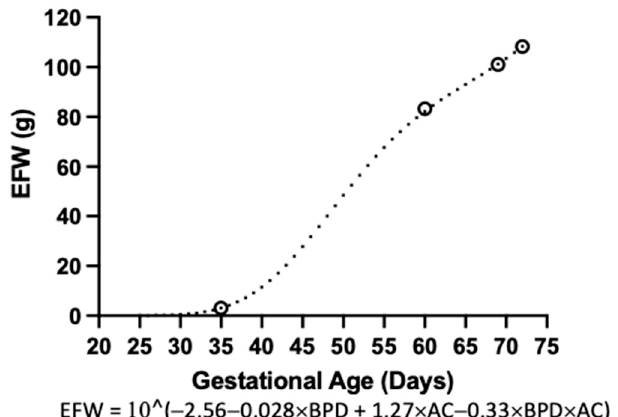
Figure 6. Guinea pig estimated fetal weight. Estimated fetal weight multiple linear regression from gestational day 25 to 72. White circles indicate timepoints where the variables were obtained (G35, n = 10; G60, n = 11; G69, n = 9; G72, n = 6). Black dots indicate the estimated fetal weight for gestational day.